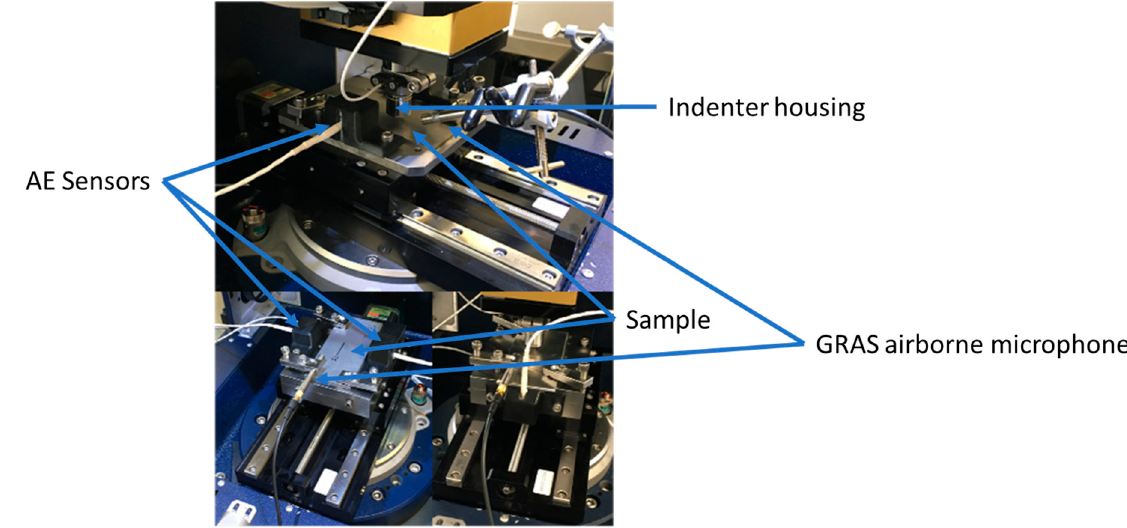
Table 1. Test Parameters/details.